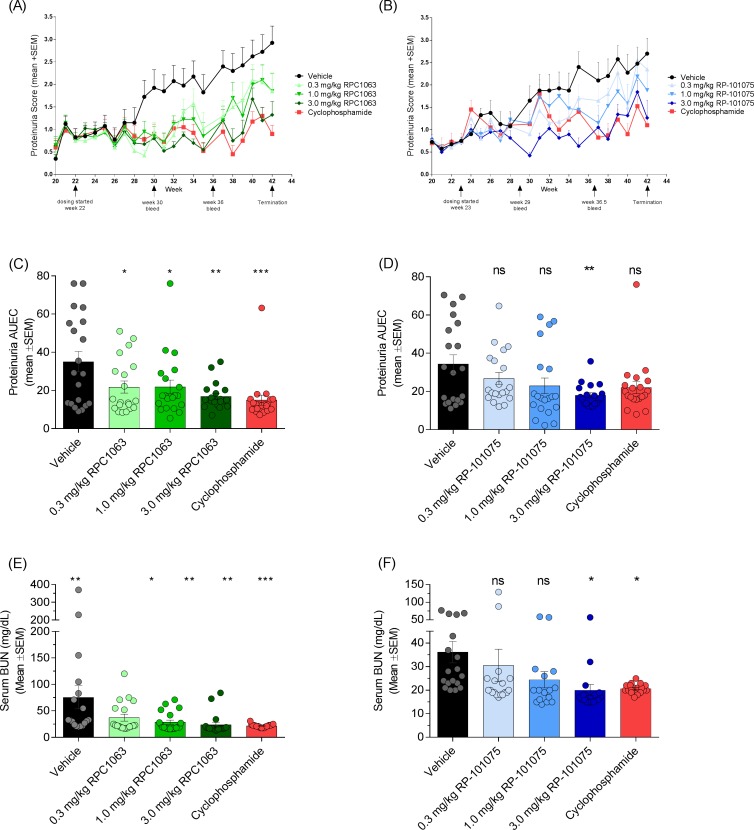
Effect of treatment on kidney function.Weekly proteinuria scores for (A) RPC1063 and (B) RP-101075 treated mice. Scores for animals that died mid-study were given a maximum score of 4.0 for the remainder of the study. Cumulative proteinuria area under the effect curve (AUEC) for (C) RPC1063, and (D) RP-101075. Serum blood urea nitrogen (BUN) at termination for (E) RPC1063 and (F) RP-101075. The normal range for mouse serum BUN levels is approximately 8–33 mg/dL (https://www.ahc.umn.edu/rar/refvalues.html). Data presented as mean ± SEM. *p <0.05, **p <0.01, ***p <0.001, ****p <0.0001, ns = not significant, for treatment versus vehicle-treated animals.